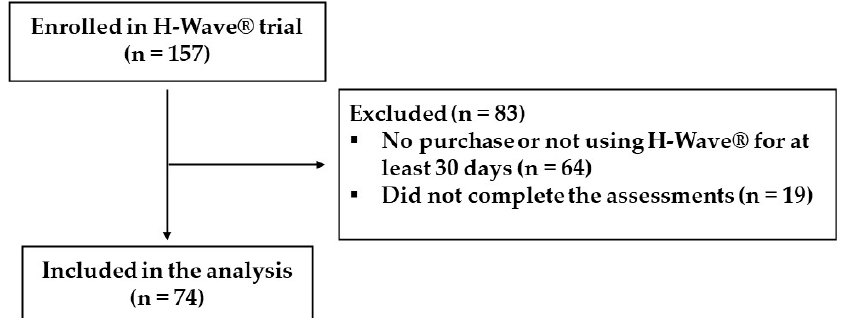
Figure 1. Inclusion/exclusion flow diagram.